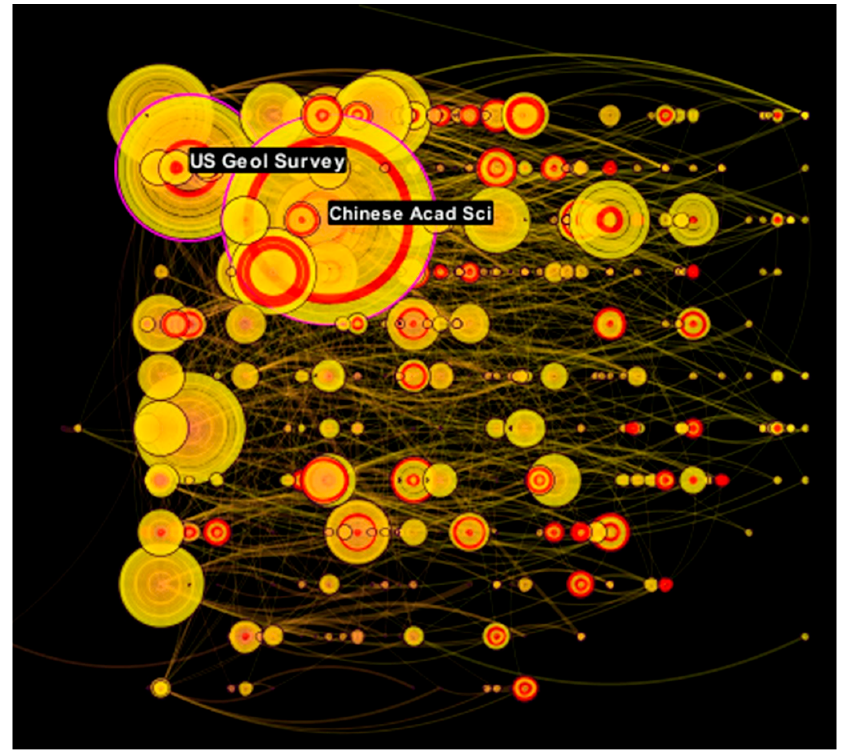
Figure 5. The top cited affiliations in studies related to the impacts of climate change on heavy metal contamination in coastal areas, based on the Web of Science Core Collection database (1979–2021).